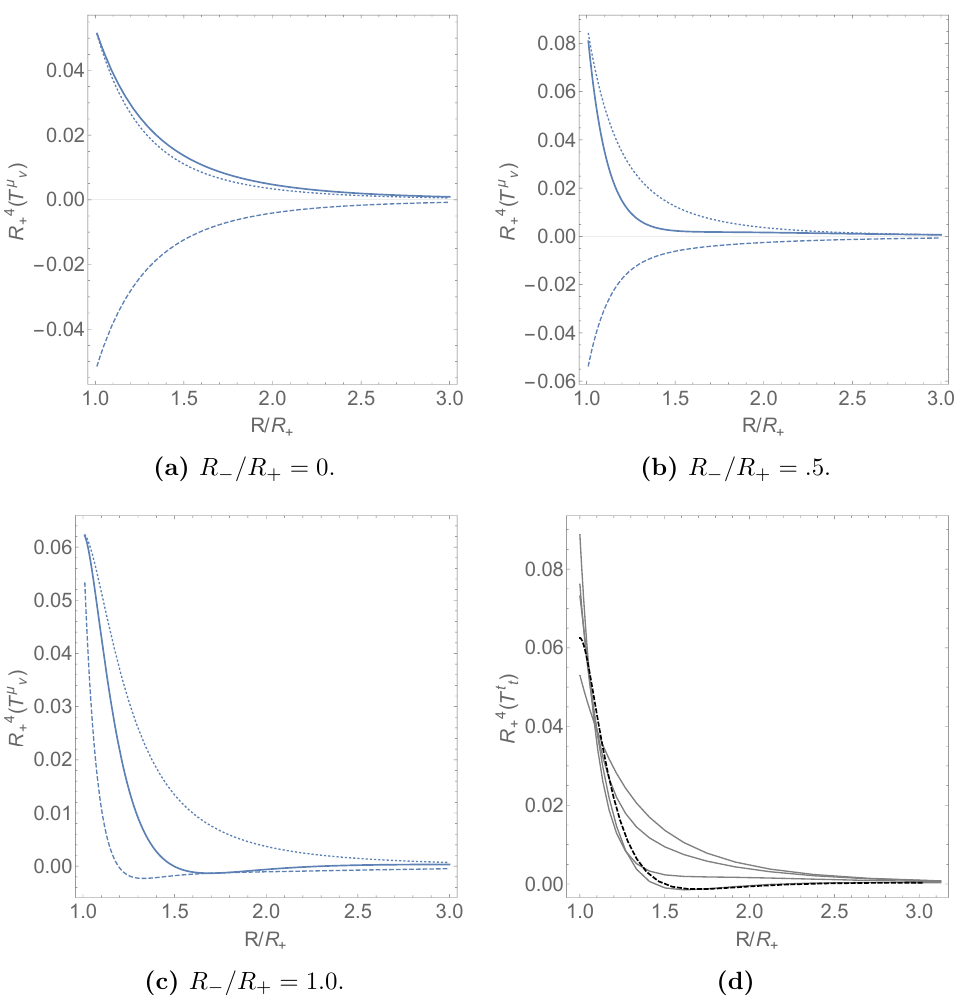
h T (cid:22) i as a function of R for di(cid:11)erent values (cid:23) l 3 , the dotted line is T r t